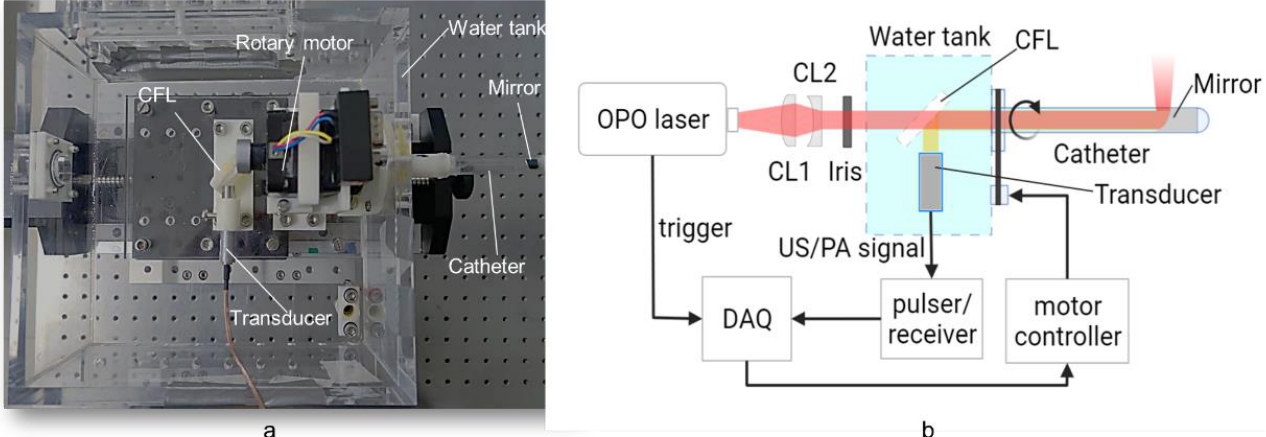
Figure 2. ( a ) Photo of the front end of the endoscopic system; ( b ) Schematic of the experimental PAE setup. CFL: Calcium Fluoride Lens; CL1: flat-convex lens; CL2: flat-concave lens; DAQ: data acquisition card.